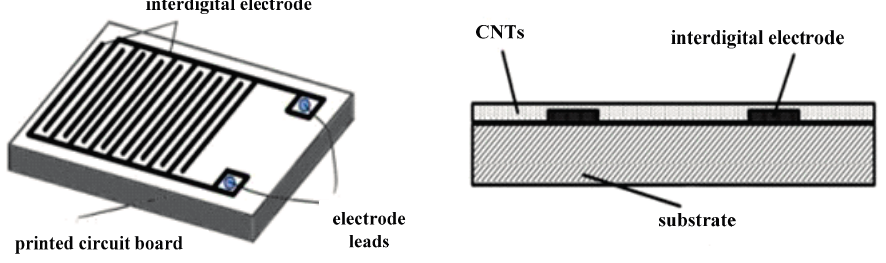
Figure 1. Sketch of the CNT sensor.